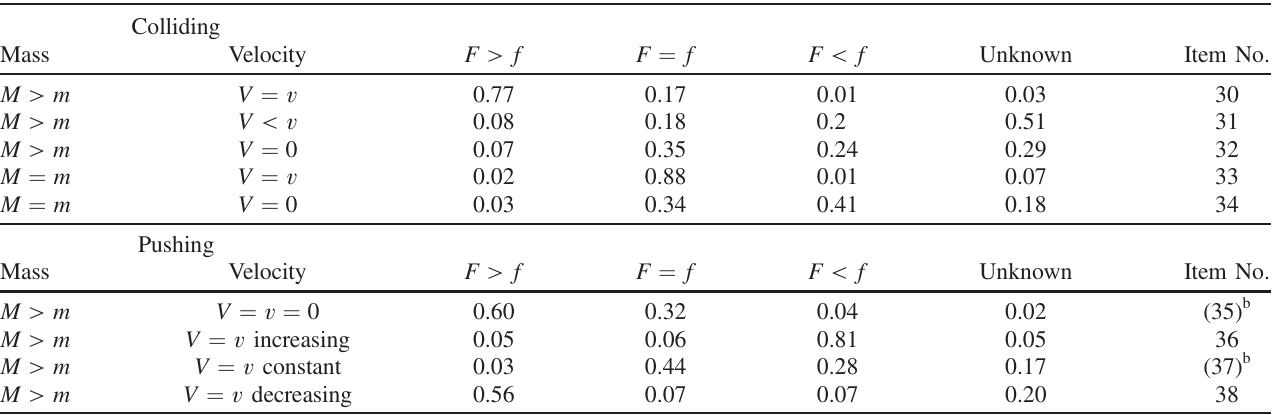
TABLE IX. Response rates for Newton ’ s third law. a